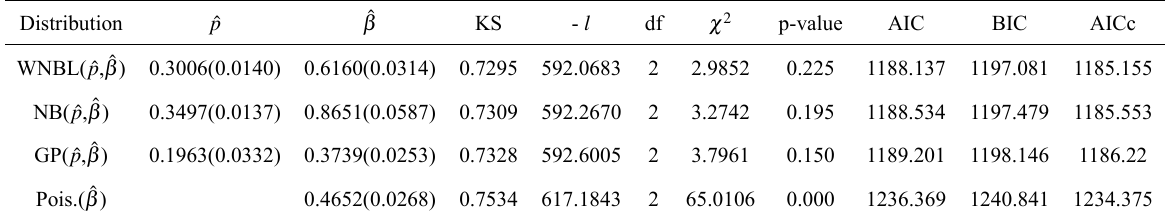
Tests Summary for data set II.